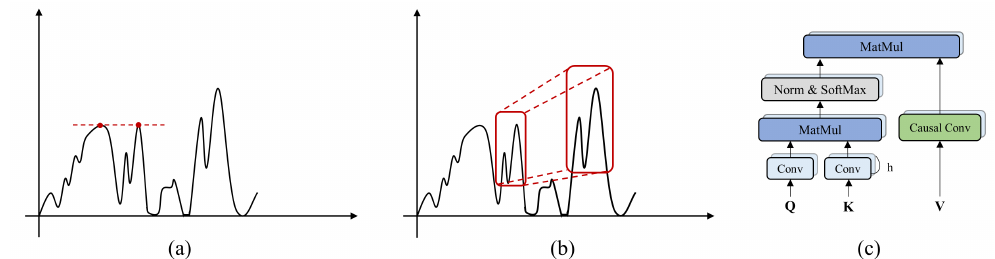
Figure 4. Comparison of traditional self-attention mechanism and our causal-trend attention mech- anism. Traditional self-attention mechanisms may incorrectly match points in the sequence with similar values shown in ( a ). Our causal-trend attention mechanism is shown in ( c ), which replaces the projection operations with 1D and causal convolution. As shown in ( b ), such awareness of locality and causality in time series can correctly match the most relevant feature in the